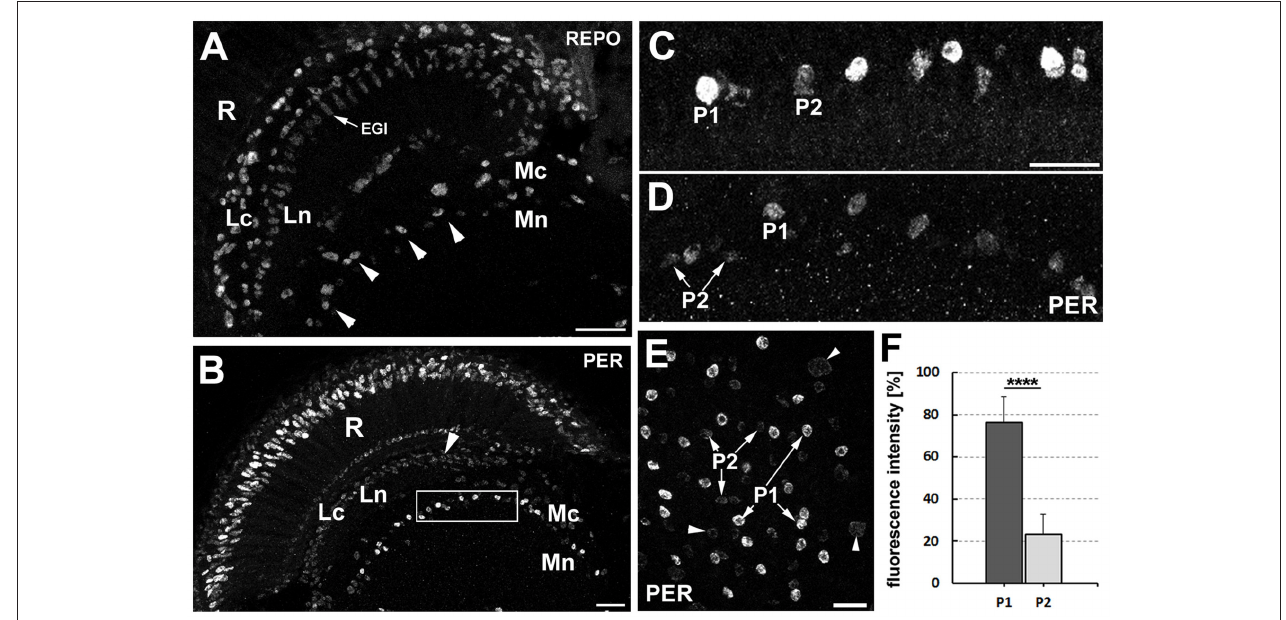
FIGURE 1 | (A) Location of the distal medulla neuropil glia (dMnGl) among other glial cells that are marked by REPO-specific immunofluorescence in the optic lobes (frontal section). The nuclei of the dMnGl (arrowheads) reside at the border between the cortex (Mc) and the neuropil (Mn) of the medulla. R, retina; Lc, lamina cortex; Ln, lamina neuropil; EGl, epithelial glial cells. Scale bar: 20 µ m. (B) Frontal section of Pdf 0 optic lobe immunolabeled with anti-PER antibody. R, retina; Lc, lamina cortex; Ln, lamina neuropil; Mc, medulla cortex; Mn, medulla neuropil. The nuclei of the dMnGl (frame) reveal high level of PER-specific immunofluorescence in comparison with the nuclei of glia in Lc (arrowhead). Scale bar: 20 µ m. (C,D) Small fragments of the Mc/Mn interface of Pdf 0 (C) and CS (D) shown in higher magnification reveal the unexpected presence of the dMnGl displaying low level of fluorescence (P2). The P2 cells are well visible in Pdf 0 (C) . They are positioned next to cells of high fluorescence (P1) in almost alternating order. Such arrangement can be also observed, although less clearly, in CS (D) . The images shown in (C,D) were collected at the same image acquisition parameters. Scale bar for (C,D) : 10 µ m. (E) The frontal surface of Pdf 0 medulla. The fluorescence in P2 is comparable to the fluorescence in glial cells of the medulla cortex (arrowheads). Scale bar: 10 µ m. (F) The average level of fluorescence ( ± SD ) in P1 and P2 cells of Pdf 0 (**** p <